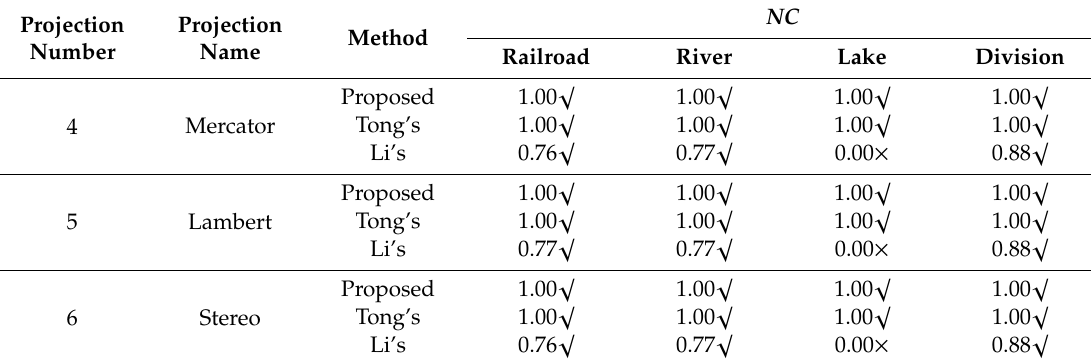
Table 6. The results after conformal projection transformation.